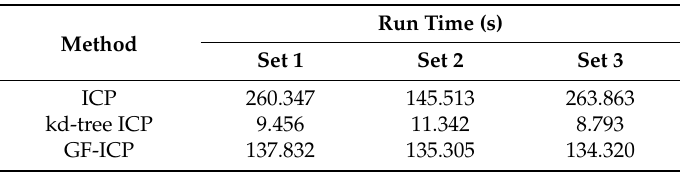
Table 1. Run time for the three ICP algorithms.